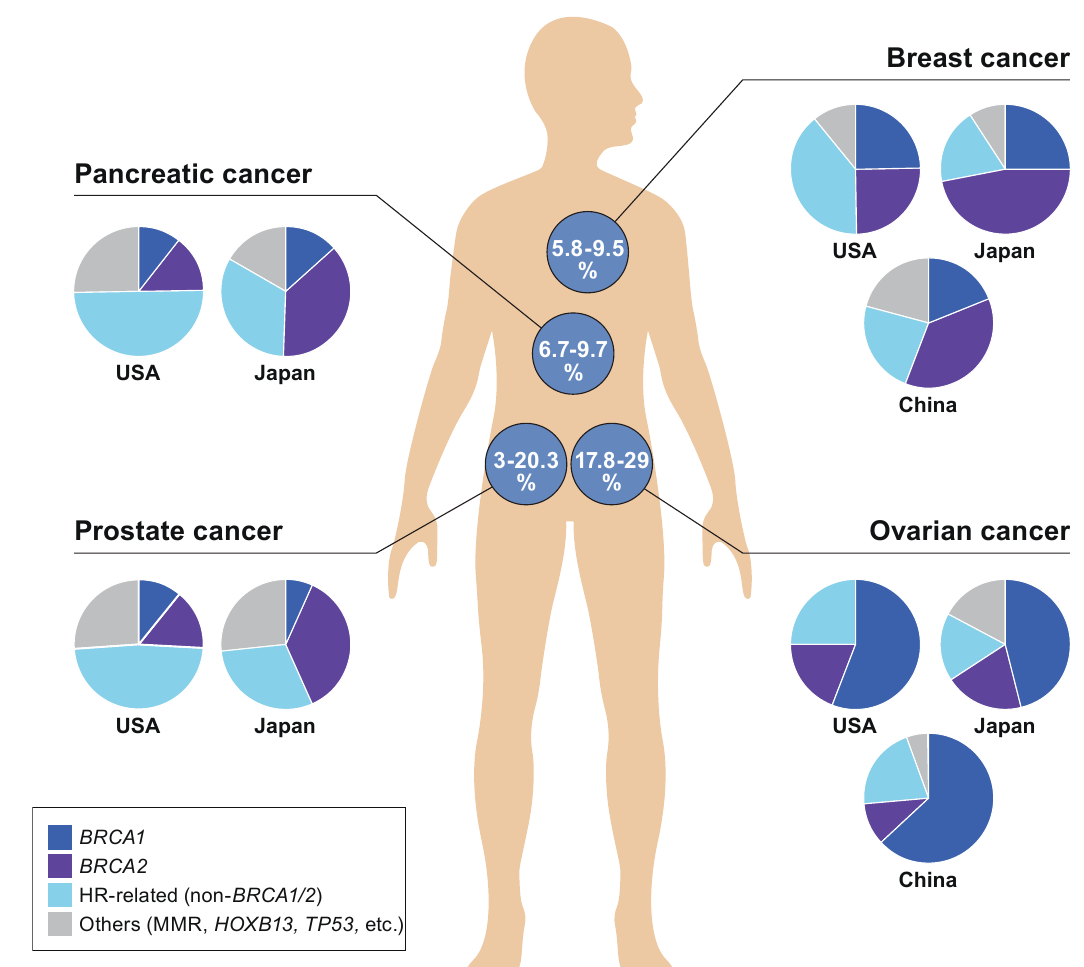
Figure 2. Prevalence of BRCA and non- BRCA in HRD-related hereditary tumors. The proportion of inheritance backgrounds due to cancer susceptibility gene alterations in each type of malignancy was summed as proportion rates (%), and is shown in circles on the human body figure. The summed rates (%) are based on the data of multi-gene panel testings (MGPTs), performed and analyzed in each country independently [47,52,111–118]. The proportions for the types of each gene alteration are categorized under any of these four groups: BRCA1 , BRCA2 , HR-related genes (non- BRCA1 / 2 ), or others (MMR, HOXB13 , TP53 , etc.), whose germline variants were determined as pathogenic/deleterious, and are shown in pie charts. Ovarian cancer includes fallopian tube and primary peritoneal carcinomas.